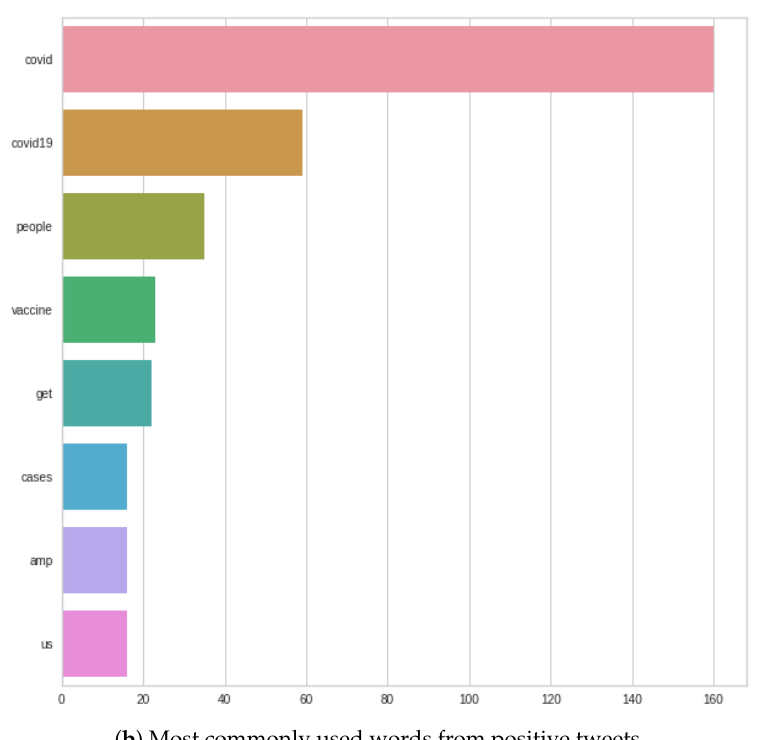
Figure 7. Most commonly used words in negative and positive tweets. The time periods stands between 29 August 2021 and 31 August